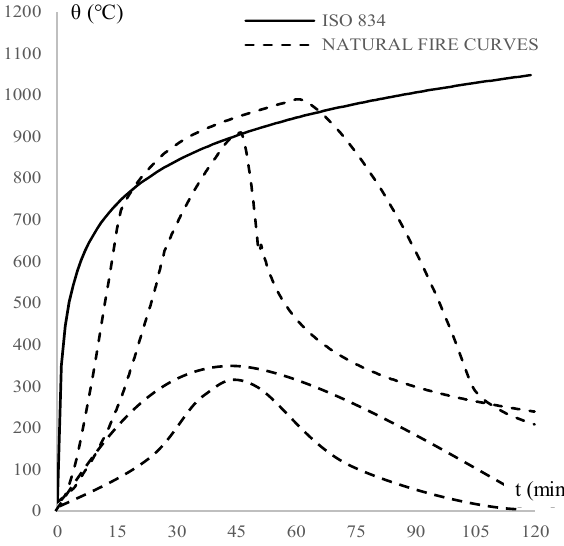
Figure 10. Natural fire curve compared with the ISO834 one.